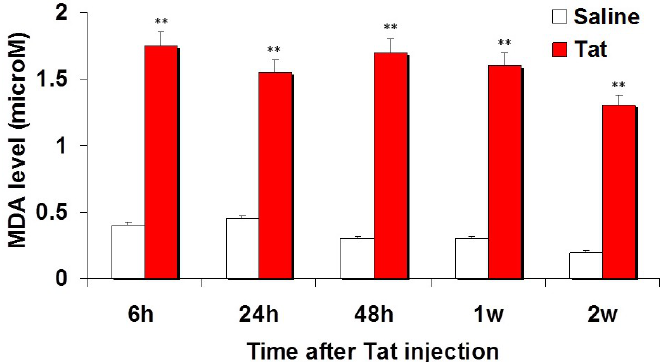
Figure 1. Graph showing the evolution of malondialdehyde (MDA) levels with time after injection of Tat in the caudate-putamen. Levels of MDA increased 6 h after injection of Tat in the CP and remained significantly elevated at the different times considered, even 2 weeks later (** p <